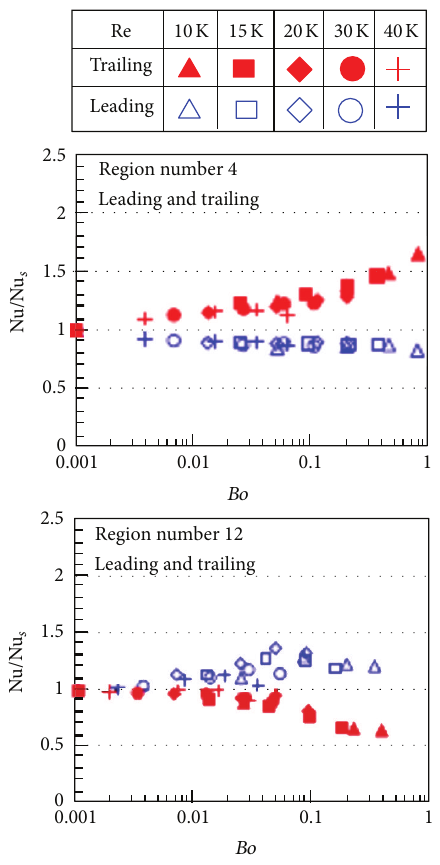
Figure 27: Local area-averaged Nusselt number ratio variations as dependent upon buoyancy parameter for the smooth surface rotating channel investigation of Huh et al. [104]. Region 4 is measured with radially outward flow, and region 12 is measured with radially inward flow.